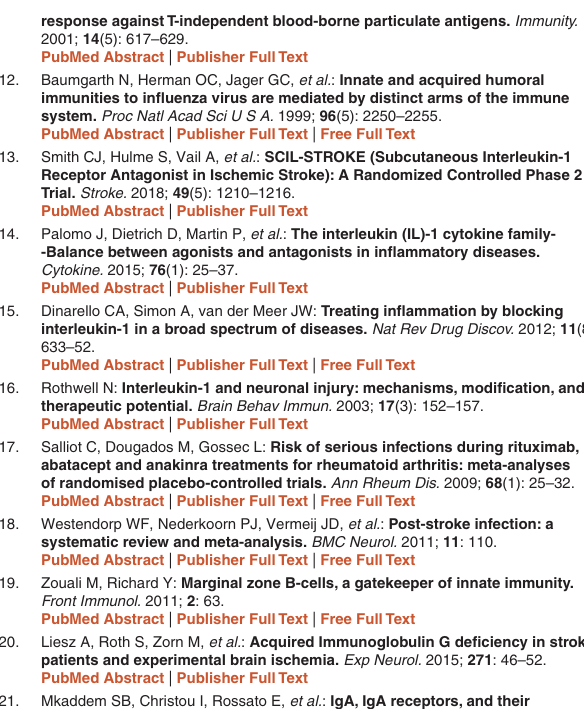
- Supplementary Table 1.tif (table of baseline characteris- tics of stroke patients and stratification of groups) - Supplementary Figure 5.tif (figure showing the percent- age of patients reaching minimum circulating concentra- tion of immunoglobulin subsets at each sampling time point) - Supplementary Figure 6.tif (figure showing the per- centage of patients reaching minimum circulating concentration of complement components reduced by stroke at each sampling time point) - Supplementary Figure 7.tif (figure showing the per- centage of patients reaching maximum circulating concentration of complement components increased by stroke at each sampling time point) - Supplementary Figure 8.tif (figure showing immuno- globulin concentration in IL-1ra and placebo treated patients at individual sampling points after stroke) - Supplementary Figure 9.tif (figure showing alterna- tive pathway complement concentration in IL-1ra and placebo treated patients at individual sampling points after stroke) - Supplementary Figure 10.tif (figure showing classi- cal pathway complement concentration in IL-1ra and placebo treated patients at individual sampling points after stroke)